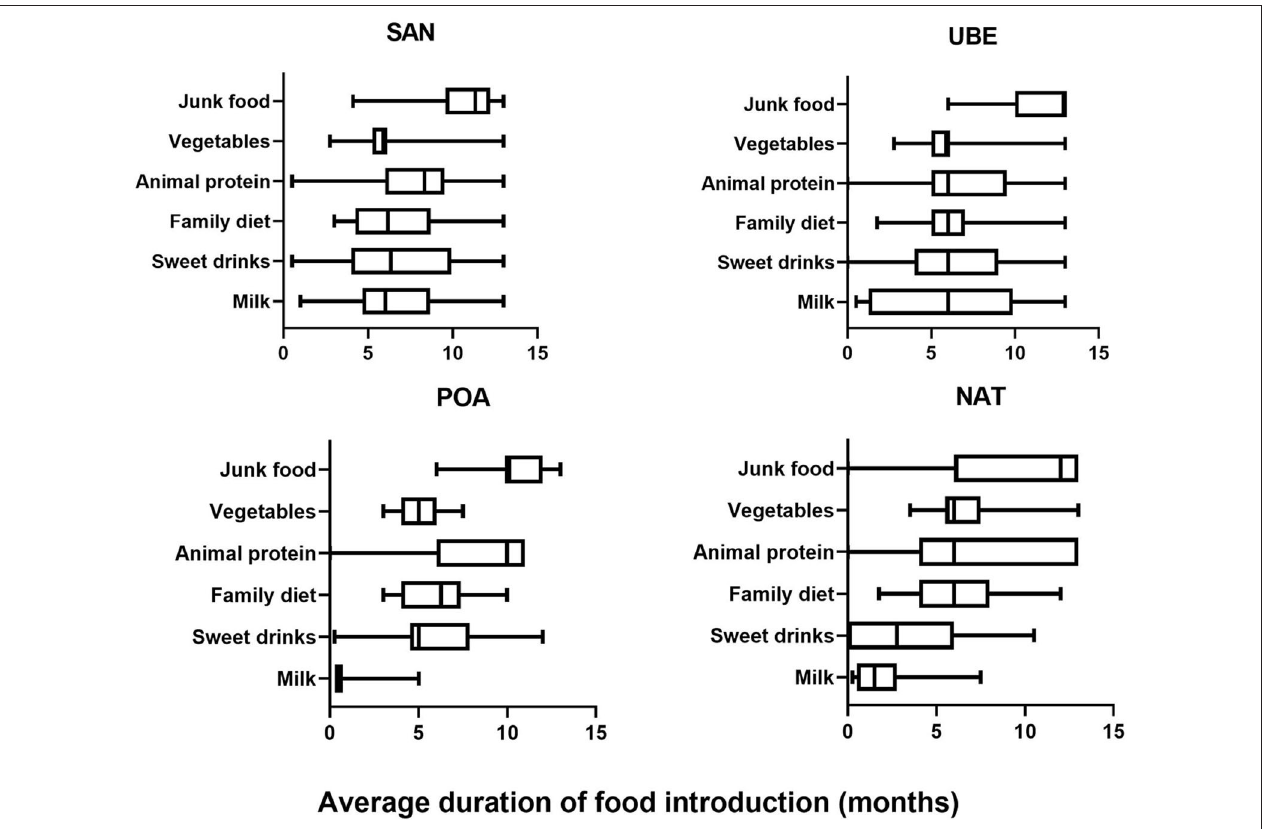
FIGURE 1 | Food diary average frequency consumed by child collected using 2-day food frequency questionnaire (FFQ) across the four cities (SAN, Santo Andre; UBE, Uberaba; POA, Porto Alegre; and NAT, Natal) showing that junk food consumption is prevalent in all four cites after the age of 1 year, while milk consumption